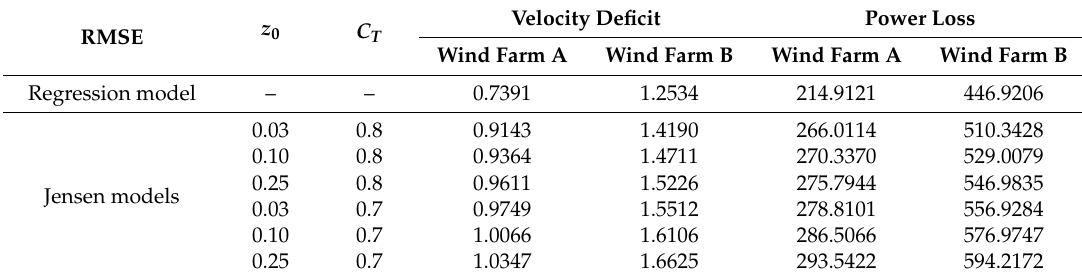
Table 5. RMSE for different